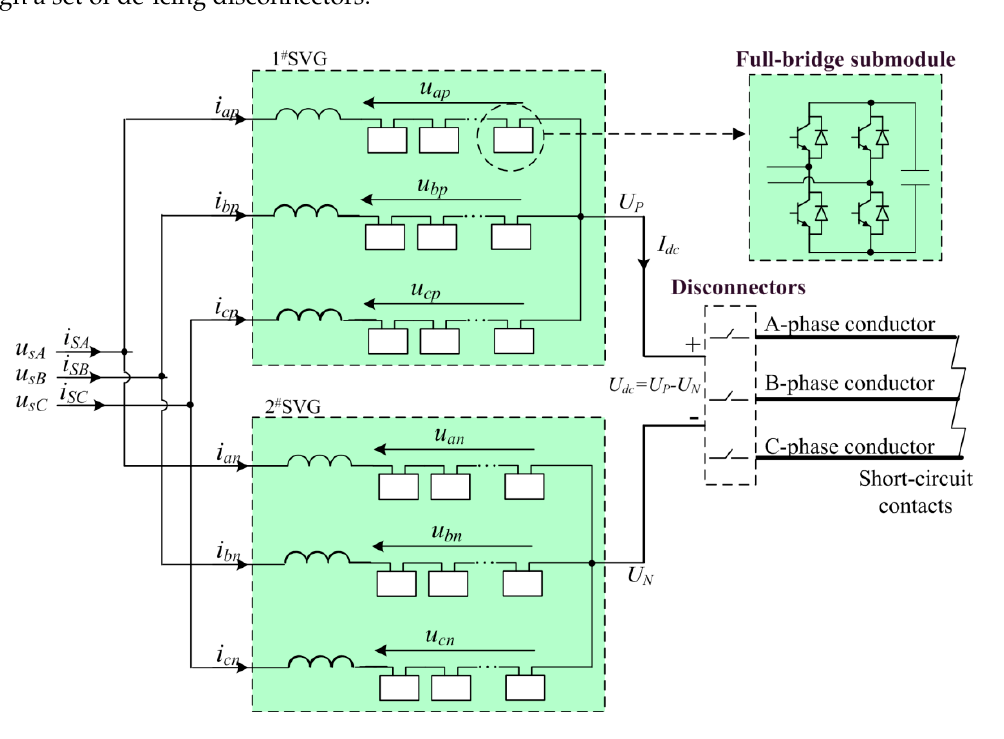
Figure 1. Circuit configuration of MMC based DC de-icer (MMC-DDI).